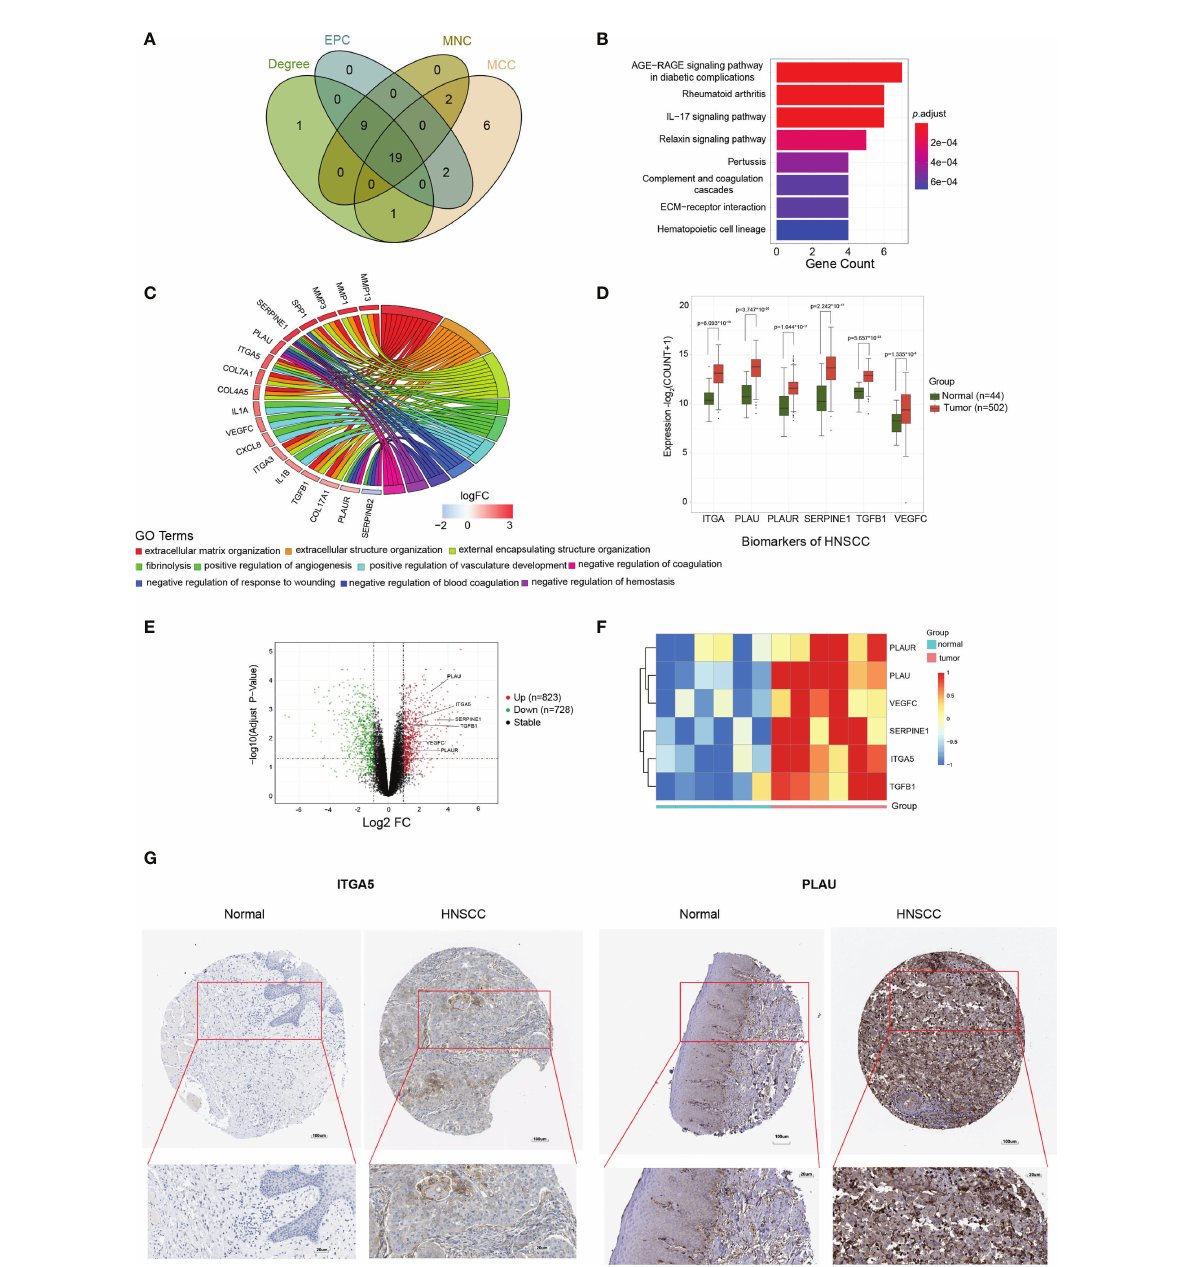
FIGURE 3 Identi fi cation and validation of the biomarkers for head and neck squamous cell carcinoma (HNSCC). (A) Venn diagram of the top 30 HNSCC- associated candidates selected by Cytoscape analysis, depending on the MCC (Maximal Clique Centrality), MNC (Maximum Neighborhood Component), EPC (Edge Percolated Component), and Degree algorithms. (B) Signi fi cant enriched Gene Ontology (GO) pathway signaling for the 19 potential biomarkers. (C) Signi fi cant enriched GO biological process terms for the 19 potential biomarkers. (D) Expression levels of ITGA5 , PLAU , PLAUR , SERPINE1 , TGFB1 , and VEGFC in tumor versus normal tissues. (E) Volcano plots showing the fold change (FC) and p -value of the biomarker candidates for the comparisons of tumor and normal tissues from the GSE138206 dataset. Upregulated (log2FC ≥ 2, p < 0.05) and downregulated (log2FC ≤ − 2, p < 0.05) genes are depicted in red and green , respectively. (F) Expression patterns of PLAUR , PLAU , VEGFC , SERPINE1 , ITGA5 , and TGFB1 in oral squamous cell carcinoma (OSCC) tumor ( n = 6) and normal ( n = 6) tissues visualized as heatmaps from the microarray. Data were z -score normalized. (G) Representative immunohistochemistry staining images of the ITGA5 and PLAU protein expression levels in tumor and normal tissues. Data were from the Human Protein Atlas